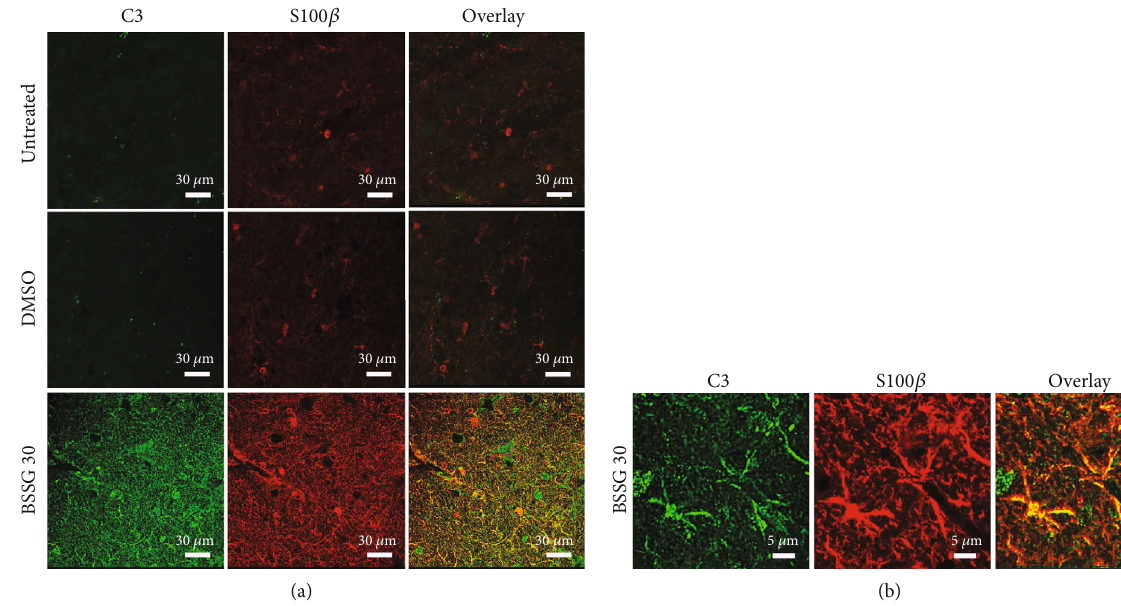
Figure 8: Cellular colocalization of C3 and S100 β immunoreactivity on day 30 after a BSSG injection in the SNpc. (a) Representative micrographs of double immuno fl uorescence of C3 and S100 β in untreated (Ut) control rats and rats injected with DMSO or BSSG. (b) Details of cells coexpressing C3 and S100 β on day 30 after a BSSG injection in the